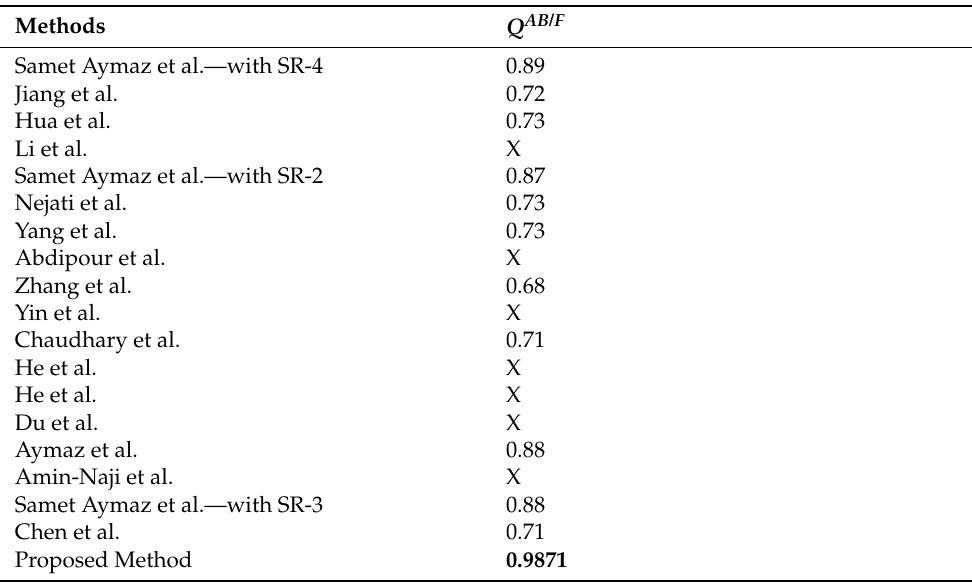
Table 14. The outcomes for the desk image and comparisons with existing techniques in the literature ([27]).